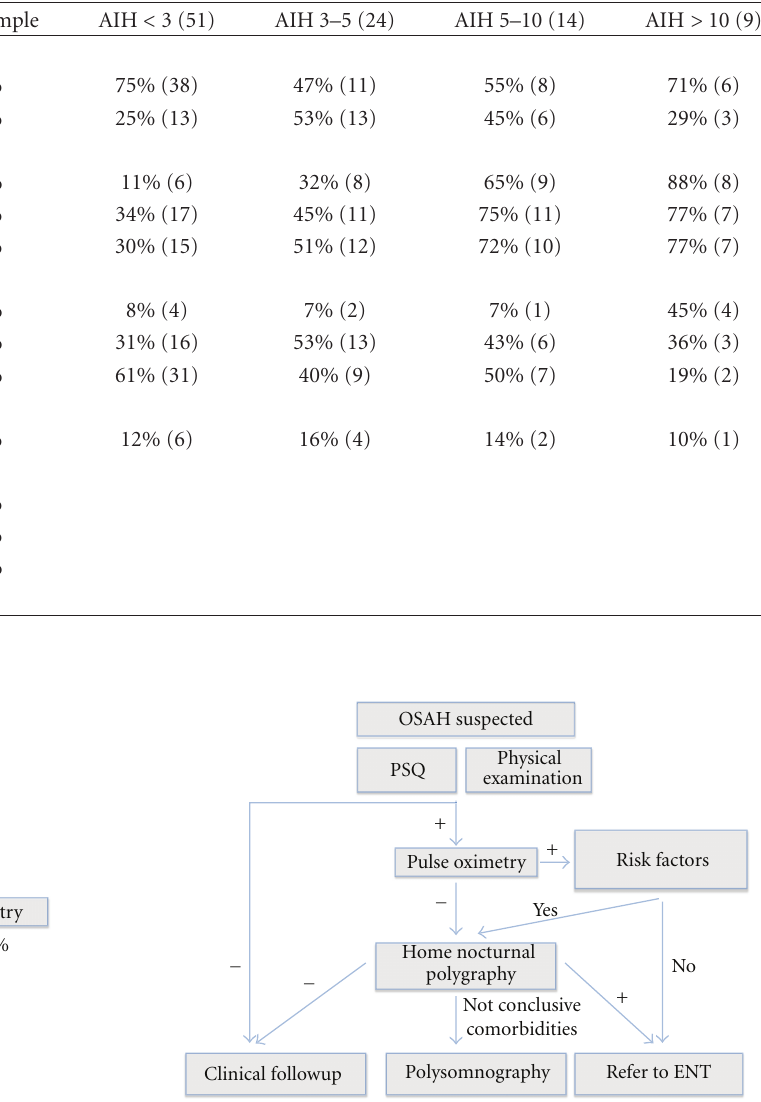
Table 1: Descriptive characteristics of cohort studied.